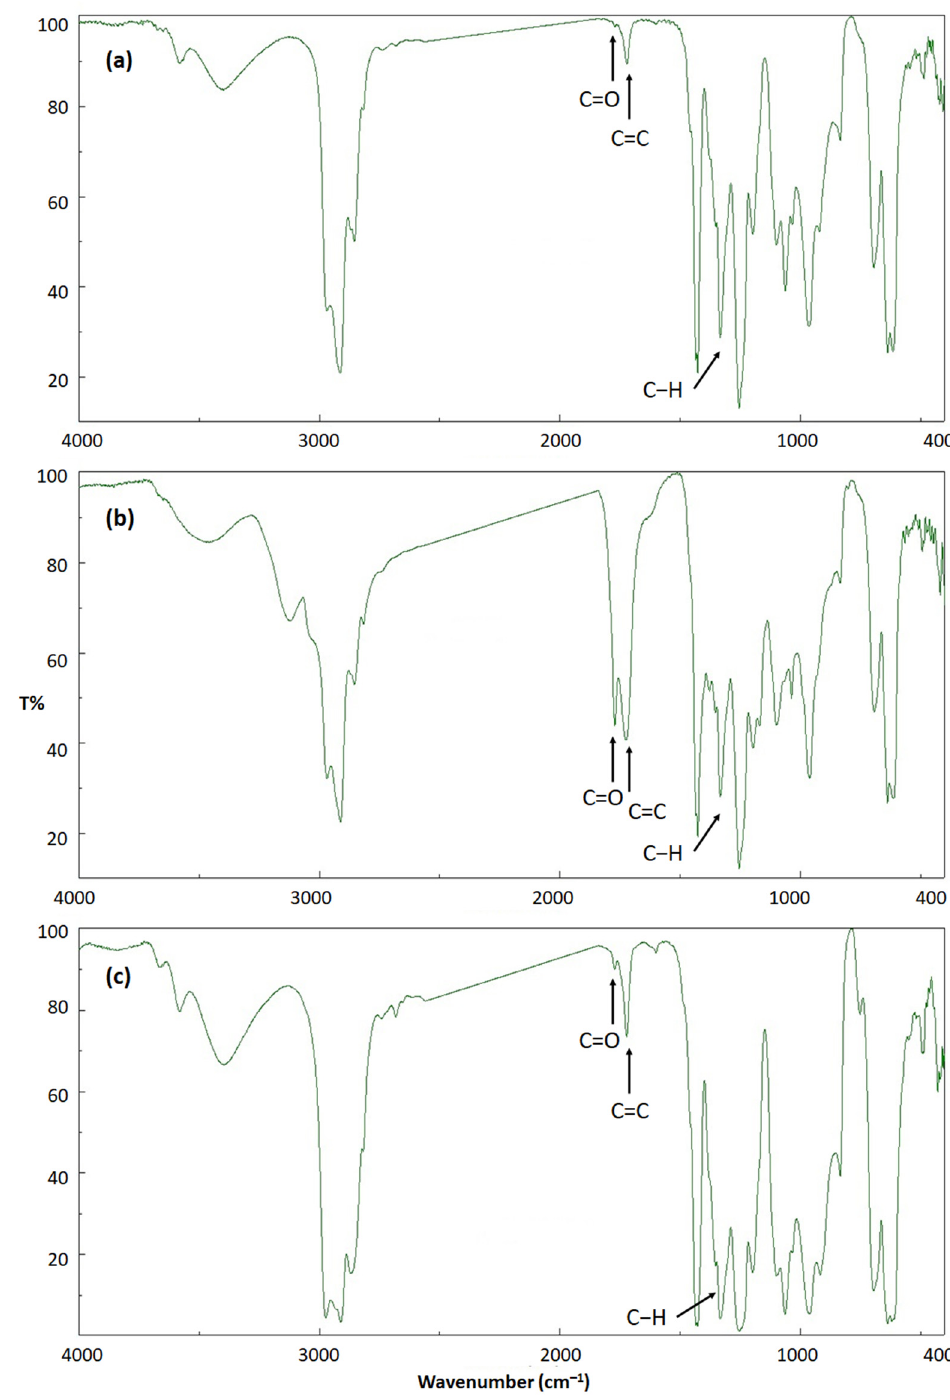
Figure 2. IR spectra of ( a ): unblended PVC before irradiation, ( b ): unblended PVC after 300 h of irradiation, and ( c ): PVC/clotrimazole/Ni NPs blend after 300 h of irradiation. After every 50 h period of irradiation, the absorbance for C=O or C=C (As) and that for the reference peak (Ar; C–H bond of the CH 2 group) were determined. The indexes (Is) for both functional groups (IC=O and IC=C) were calculated using Equations (1) and (2) based on both the transmi tt ance (T) and absorbance (A) [55]. Figures 3 and 4 show the changes in both the I c=o and I c=c during irradiation, respectively.